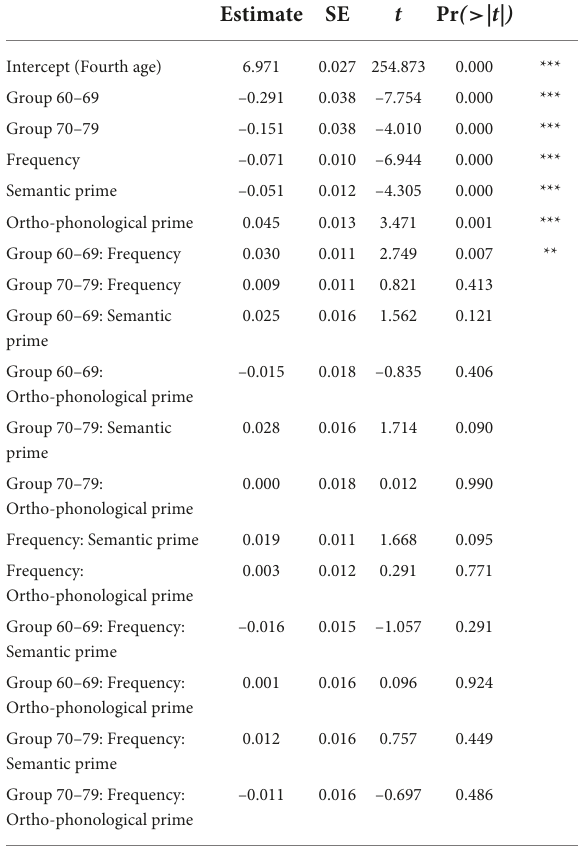
TABLE 3 Linear mixed-effects regression reaction time results for Experiment